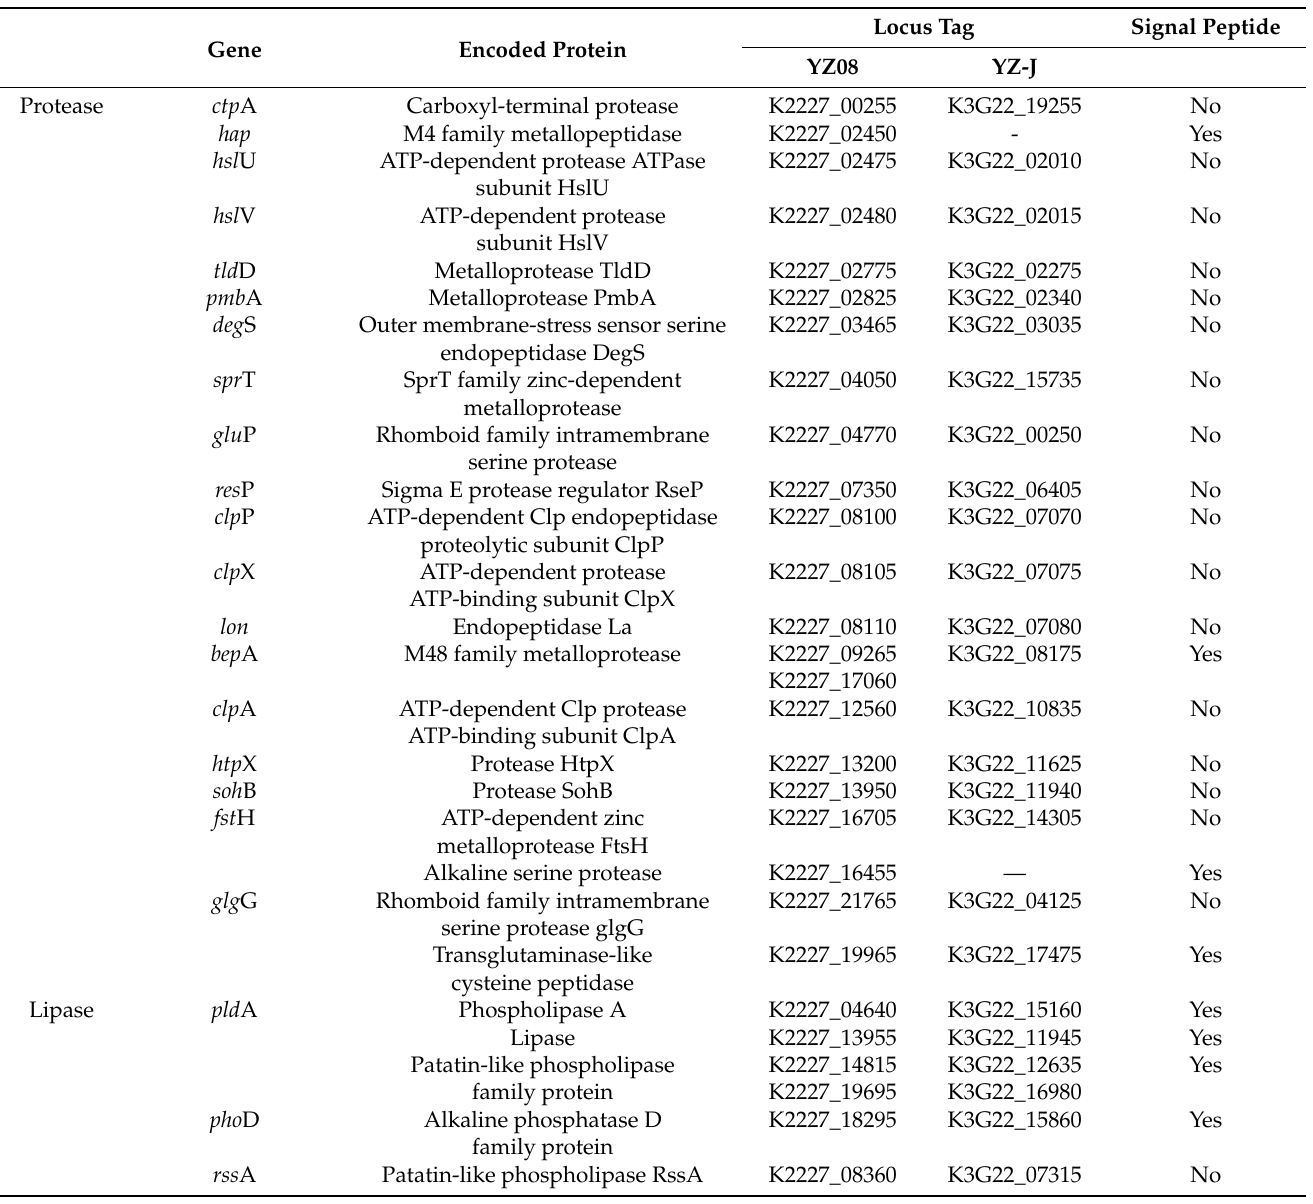
Table 3. Genes encoding proteases and lipases of S. putrefaciens YZ08 and